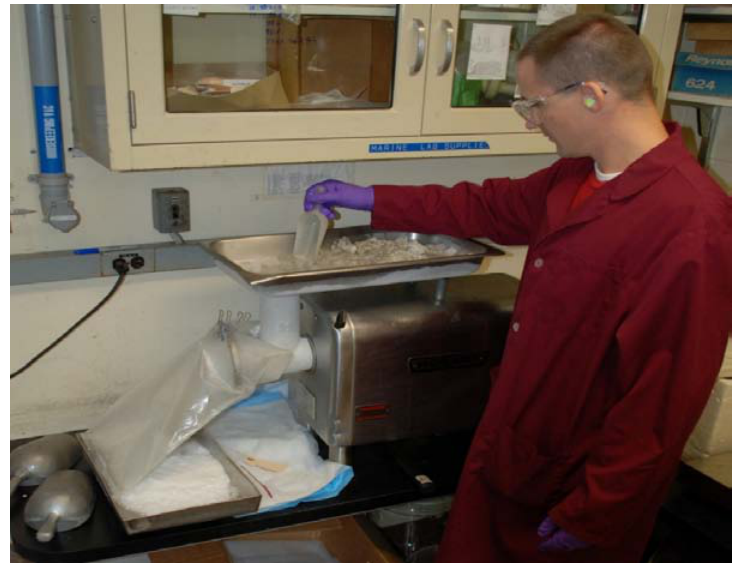
Figure 10. Grinding of marine organism tissue mixed with dry